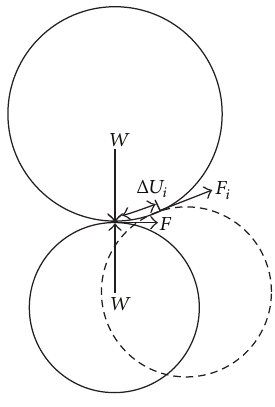
Figure 1: Friction between particle balls.